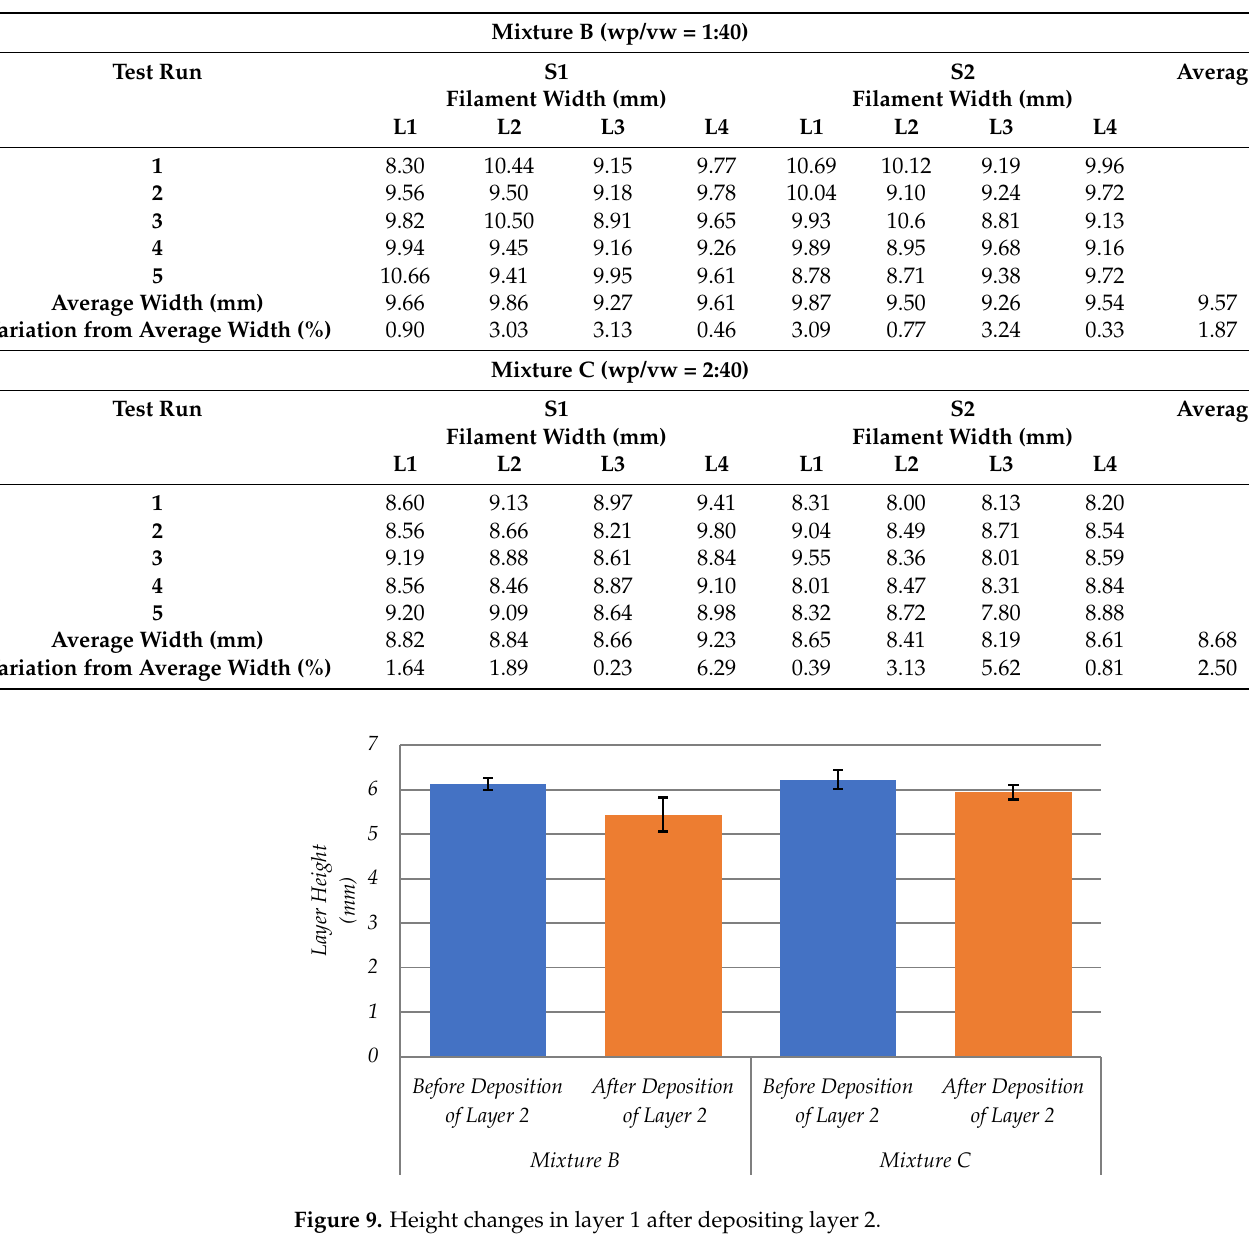
Table 2. Filament width data for samples S1 and S2 printed using Mixtures B and C.